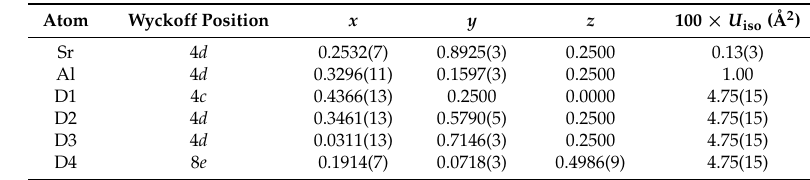
Figure 1. ( a ) The Rietveld refinement fits of (upper) SR-PXD ( Rwp = 0.0306) with λ = 0.5053 Å and (lower) PND ( Rwp = 0.0429) with λ = 1.5539 Å for SrAlD 5 and ( b ) the crystal structure of SrAlD 5 viewed along the a-axis (upper) and c-axis (lower). Purple, yellow and blue spheres and light–green octahedra represent Sr, Al, D and AlD 6 , respectively. In the Rietveld refinement fits of SR-PXD and PND, the observed, calculated background and difference between observed and calculated patterns are indicated with circles, a red, green and blue lines, respectively. The Bragg reflection positions are shown for (top) SrAlD 5 , (middle) Al and (bottom) SrD 2 . The refined weight fractions of SrAlD 5 , Al and SrD 2 were 75 wt % (84 wt %), 20 wt % (13 wt %) and 5 wt % (3 wt %), respectively (PND are provided in parentheses). Table 1. Crystallographic parameters for SrAlD 5 with a = 4.6226(10) Å, b = 12.6213(30) Å and c = 5.0321(10) Å obtained from both of SR-PXD and PND in the space group Pbcm (No. 57) and Z = 4. The U iso of Al was not refined and the occupancies of each atomic position were fixed as 1.00. Estimated standard deviations are in parentheses.